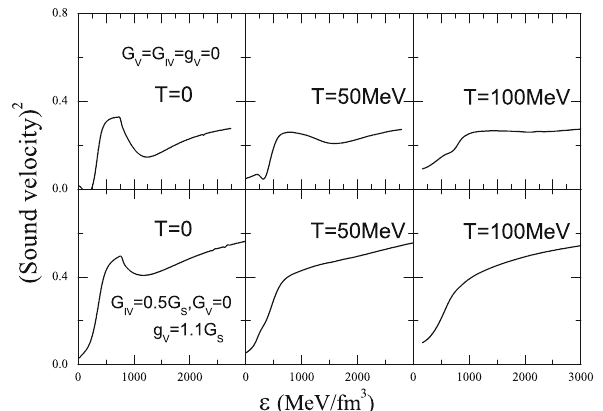
Fig. 6 The sound velocity square as a function of energy density for SQM at T = 0 , 50 and 100 MeV with different sets of parameters